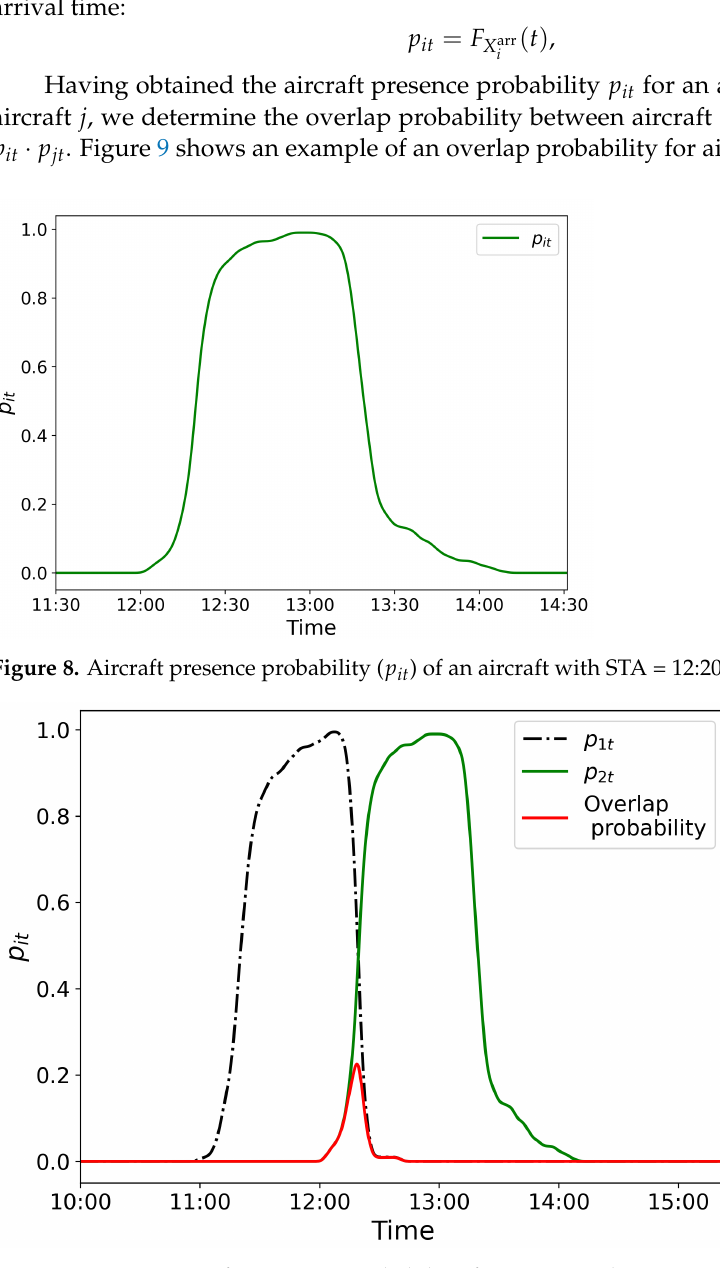
Figure 9. Two aircraft presence probability functions with STA 1 = 11:20, STD 1 = 12:00, STA 2 = 12:20, STD 2 = 13:10, and their overlap